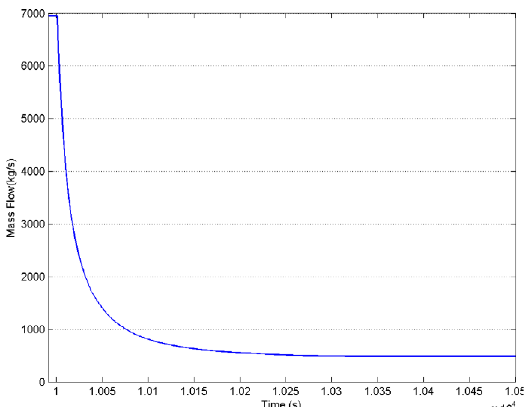
Fig. 7. Coolant mass fl ow in one loop (3D).